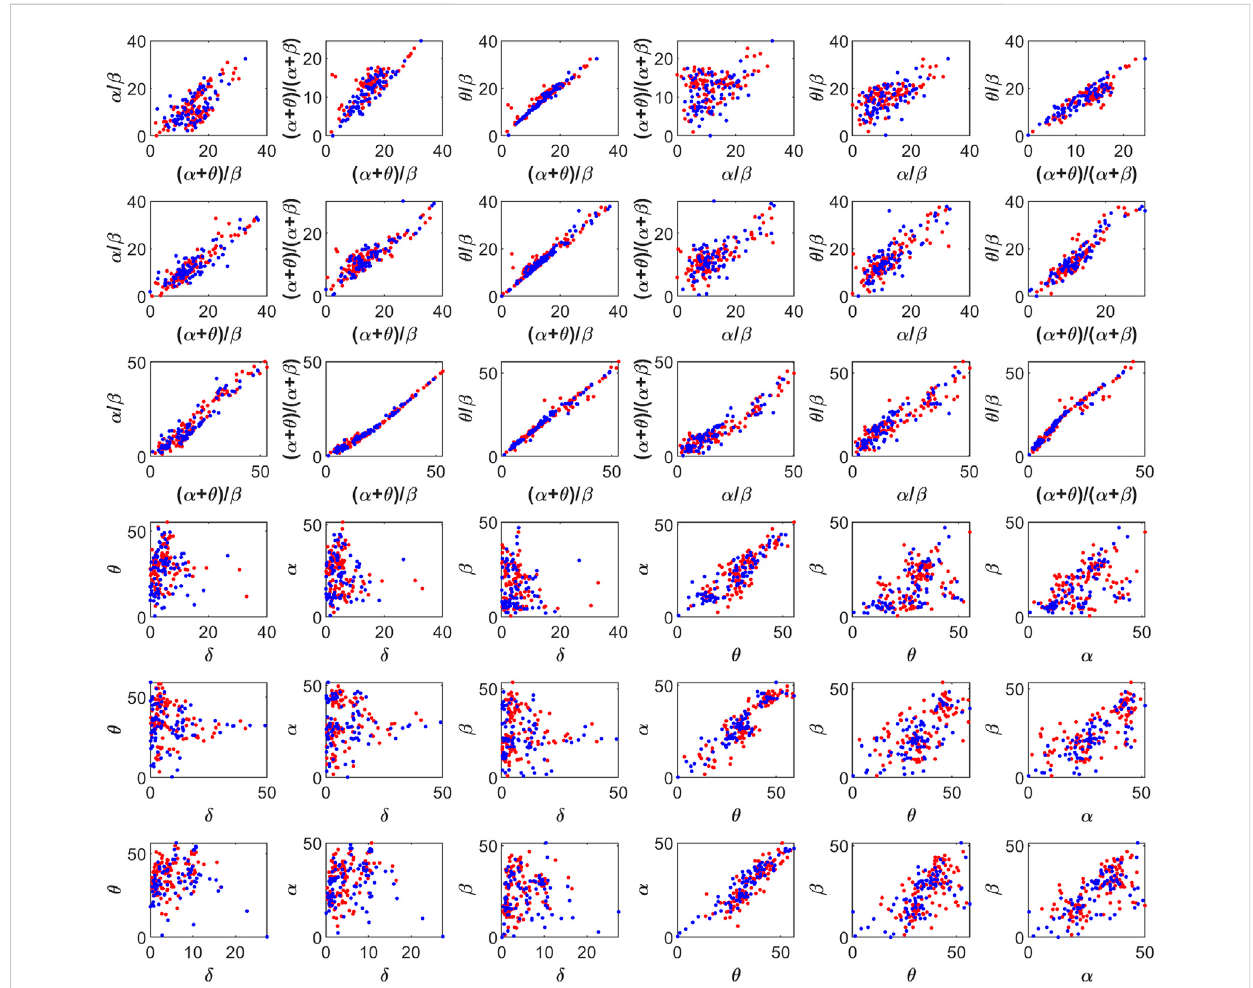
FIGURE 3 2Dscatterplotsonalogscaleforfeaturepairsbetweenbandpowerratios(topthreerows),andspectralbandpowers(bottomthreerows).Fp1,Fp2, O1, O2, F7, and F8 channels in each row from top to bottom, respectively. Red and blue data points represent drowsy and alert states,